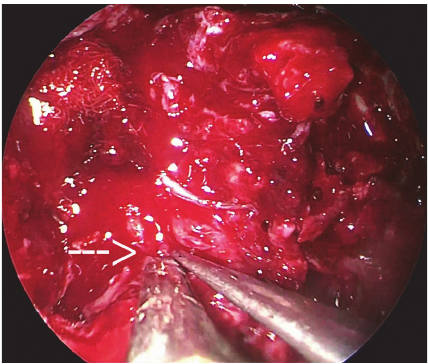
Figure 2: Endoscopic view showing the tumor ( ∗ ) being dissected with constant transaction.